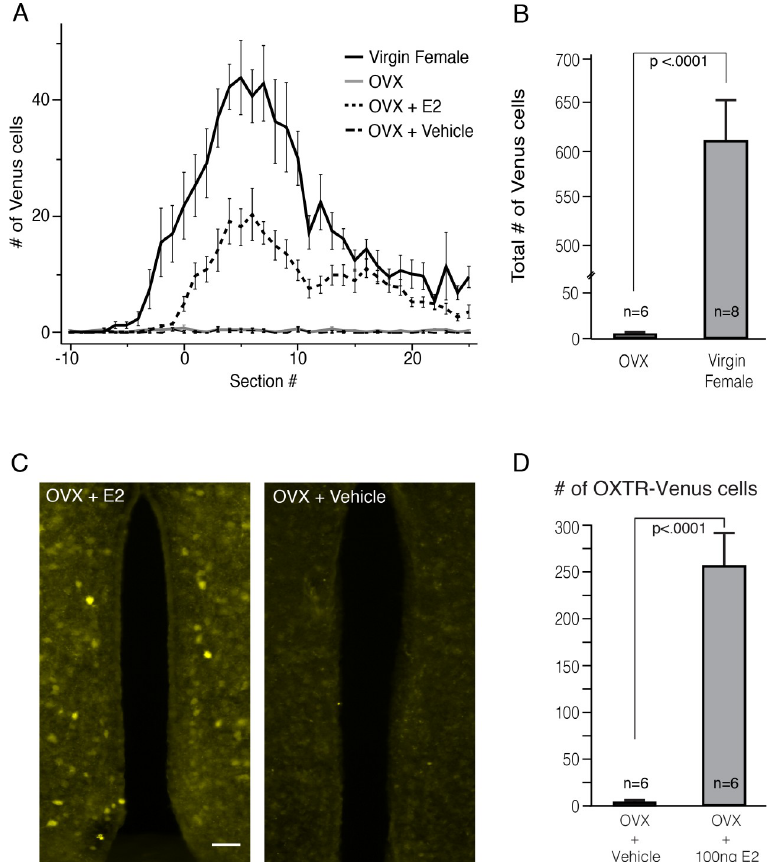
Fig 6. Expression of OXTR in the sexually dimorphic OXTR-neurons is supported by estrogen. A. Plot of the average number of OXTR-Venus neurons in the AVPV/section in the serial sections from the OVLT to SCN in intact, OVX, OVX+E2, and OVX+Vehicle female mice. B. The mean total number of OXTR-Venus cells in the AVPV from intact female and OVX. The mean total number of OXTR-Venus cells in OVX was significantly lower than that of females. C. Fluorescence microscopic images of OXTR-Venus cells in the AVPV from an OVX+E2 and an OVX +Vehicle. The group of OXTR-Venus cells observed in the AVPV in the intact females was not observed in OVX +Vehicle; however, the group of OXTR-Venus cells was observed in the OVX+ E2 mouse. D. The mean total number of OXTR-Venus cells in the AVPV of OVX+E2 was significantly higher than that of OVX+Vehicle. All numerical data are expressed as the mean ±